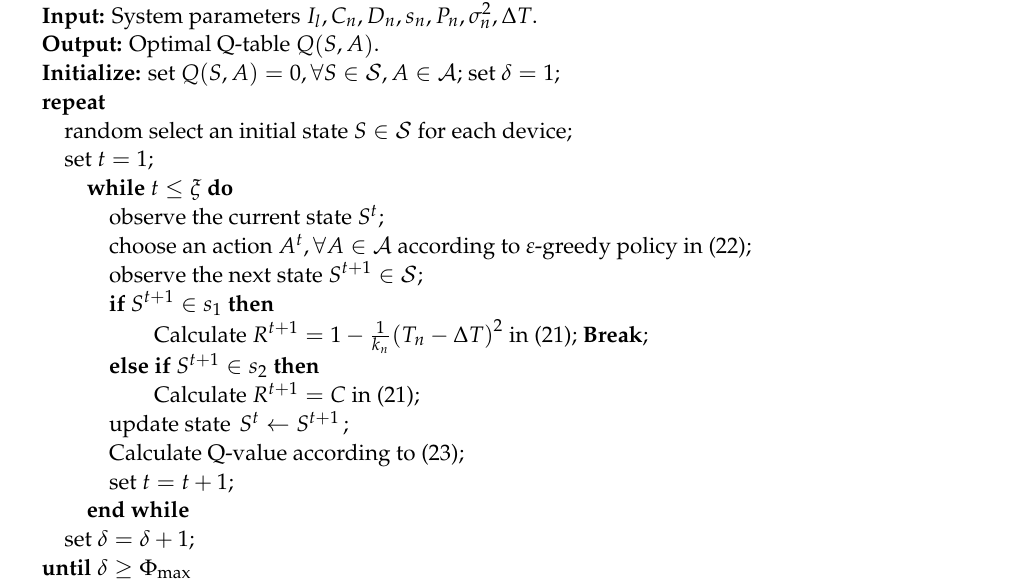
Algorithm 2: Q-Learning-Based Offloading Strategy with Imperfect